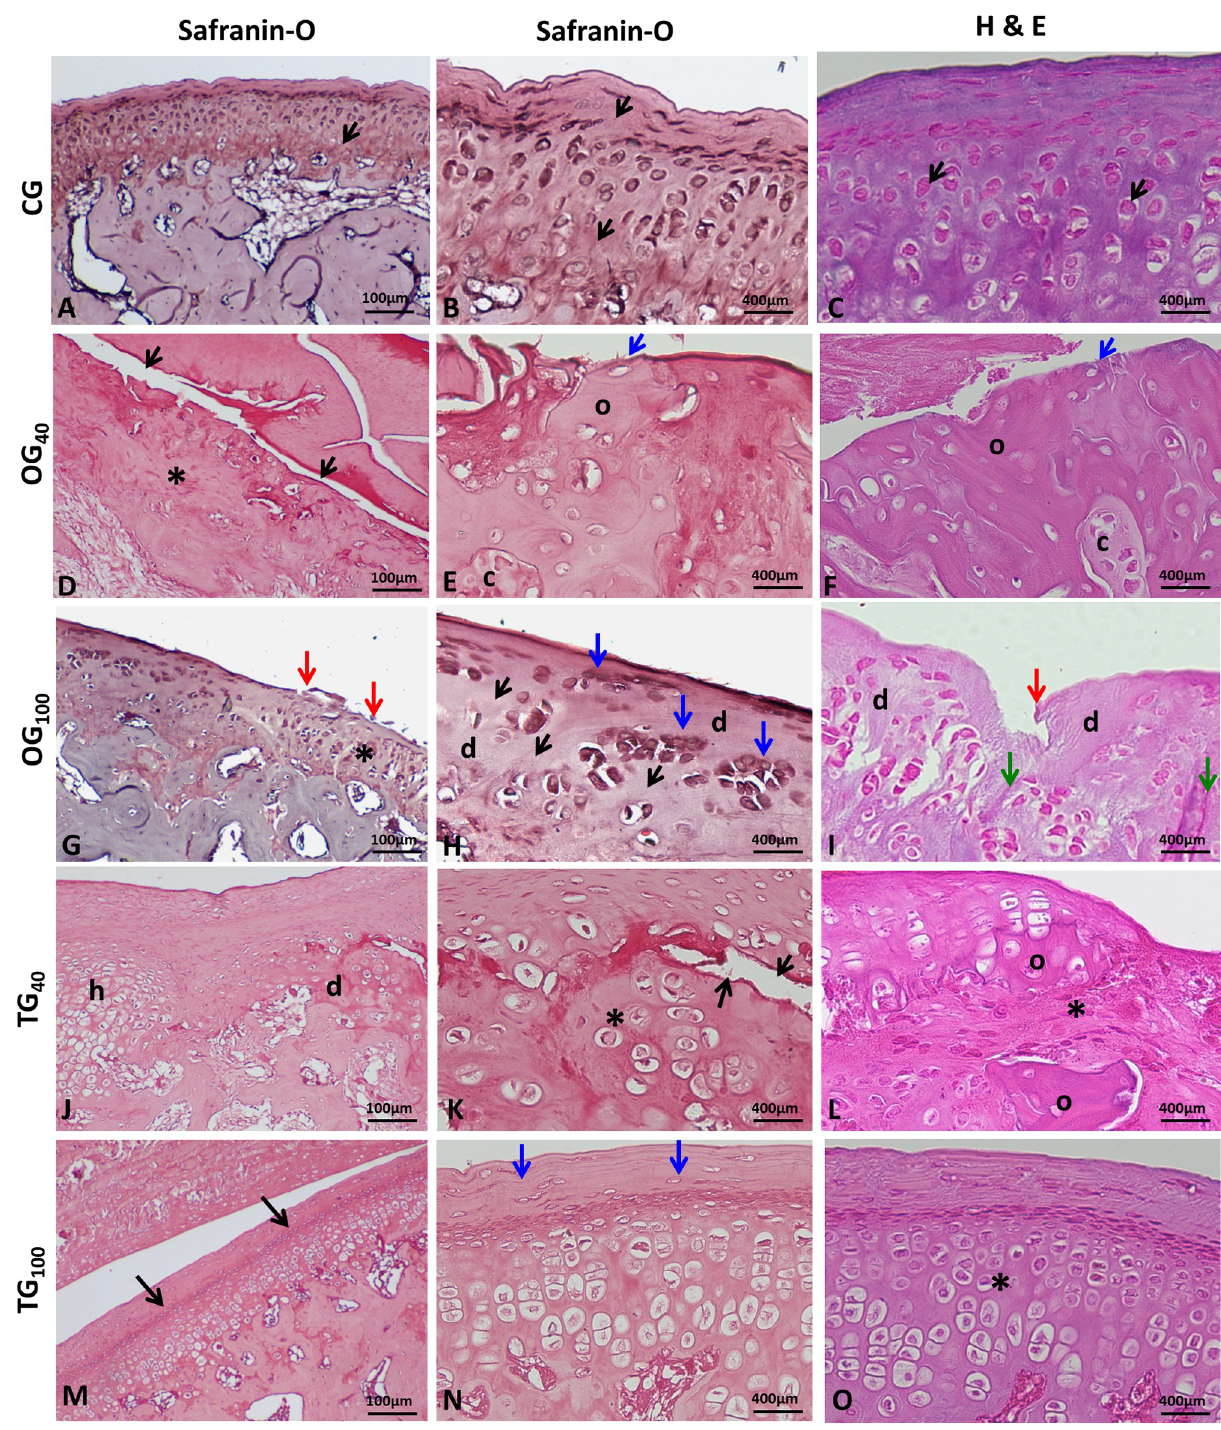
Fig 5. Histologic appearance of the mandibular condyle surface. (A, B, and C) Control group—Normal articular cartilage layer; safranin O staining indicating normal presence of proteoglycans (black arrows); normal presence of chondrocytes and ossification process (red arrows). (D, E, and F) OG40 —Ill-defined articular cartilage and cell degeneration ( � ); presence of cracks (black arrows); loss of cartilage matrix and fibrous connective tissue (blue arrows); areas of superficial heterotopic ossification (o) involving cartilage regions (c). (G, H, and I) OG 100 —Decreased cartilage thickness and subchondral irregularities ( � ); reduced safranin O staining indicating loss of proteoglycans (black arrows); erosion and discontinuity of cartilage surface (red arrows); cell clustering (blue arrows) close to areas of cell degeneration (d); areas of fibrillation (green arrows). (J, K, and L) TG40—Hypertrophic